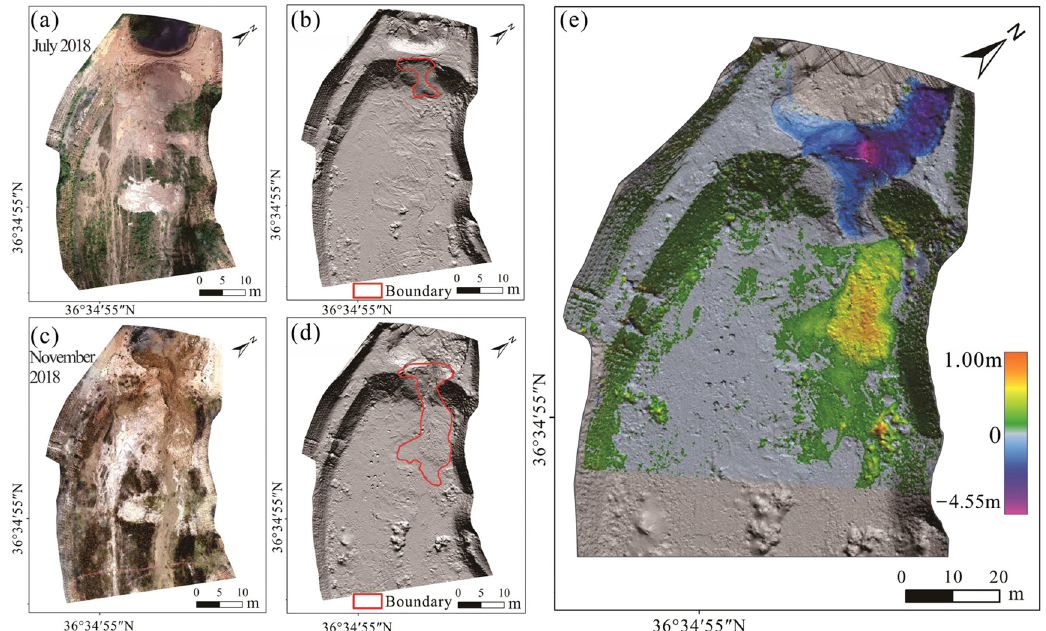
Figure 14. Topographic changes in the selected silt dam. ( a , b ) DOM and DEM of the dam on 15 July 2018; ( c , d ) DOM and DEM of the dam on 7 November 2018; ( e ) topographic changes in the dam from 15 July 2018, to 7 November 2018. The red polygons in panels ( b , d ) highlight the deformed areas of the silt dam.